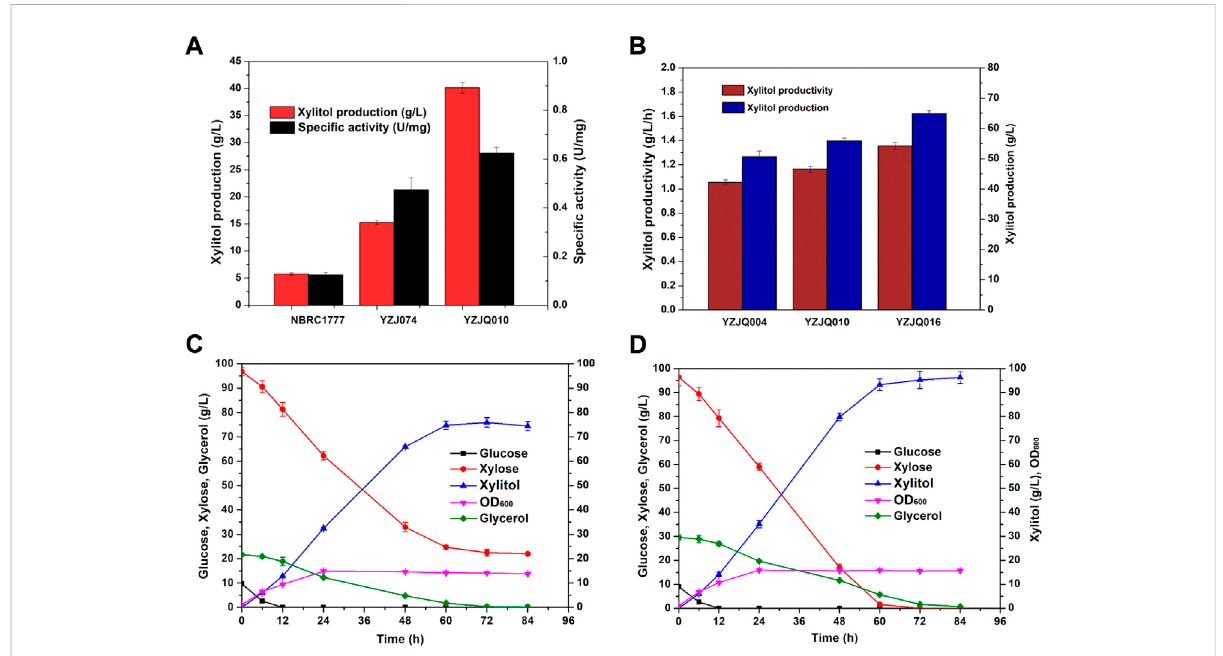
FIGURE 5 The glucose – xylose co-fermentation ability was further improved by keeping the redox balance. (A) The XR activity and xylitol production of different strains. (B) Co-fermentation of 10 g/L glucose, 100 g/L xylose, and 20 g/L glycerol at 42 ° C with YZJQ004, YZJQ010, or YZJQ016 for 48